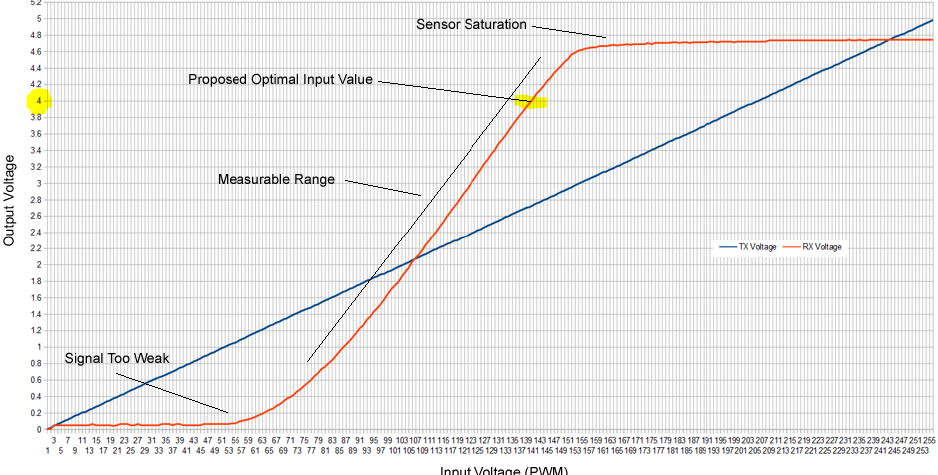
Figure 10. Example electrical response of the sensor to different input pulse width modulation values.